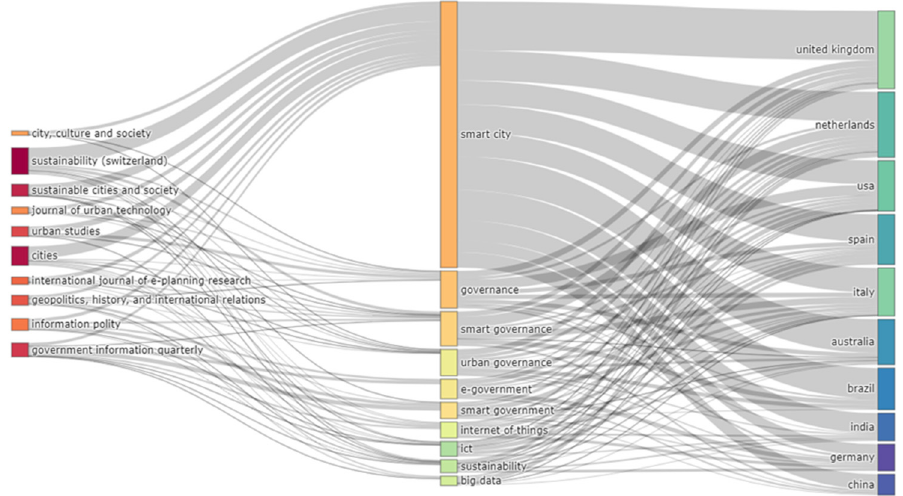
Figure 7. Three Field Plot: Relationship between the sources ( left ), main author keywords ( middle ), and countries ( right ) for SPG research. Note: The analysis is conducted on just (n = 488) articles and based on sources, authors’ main keywords, and countries.